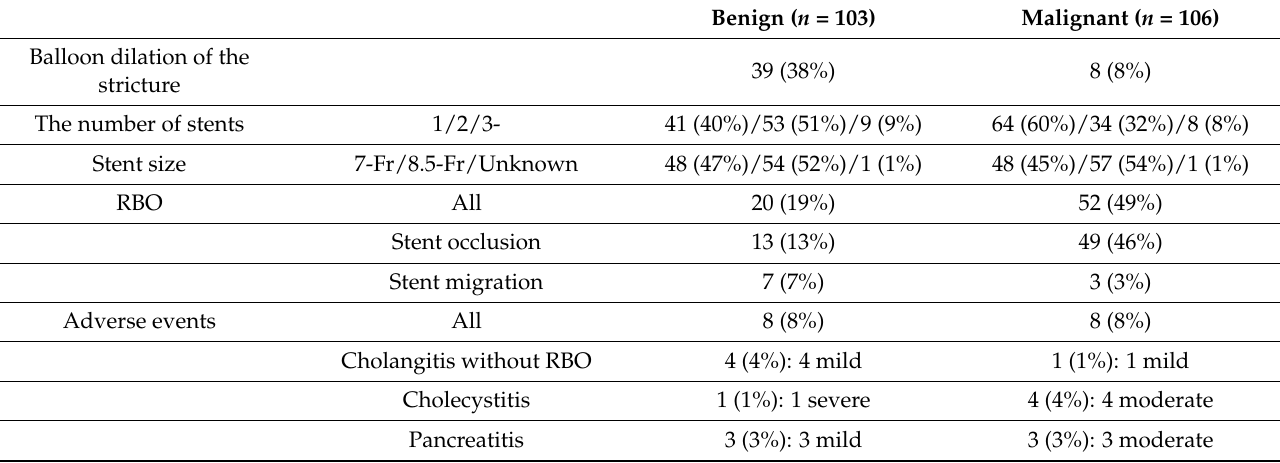
Table 2. Procedure details and clinical outcomes per